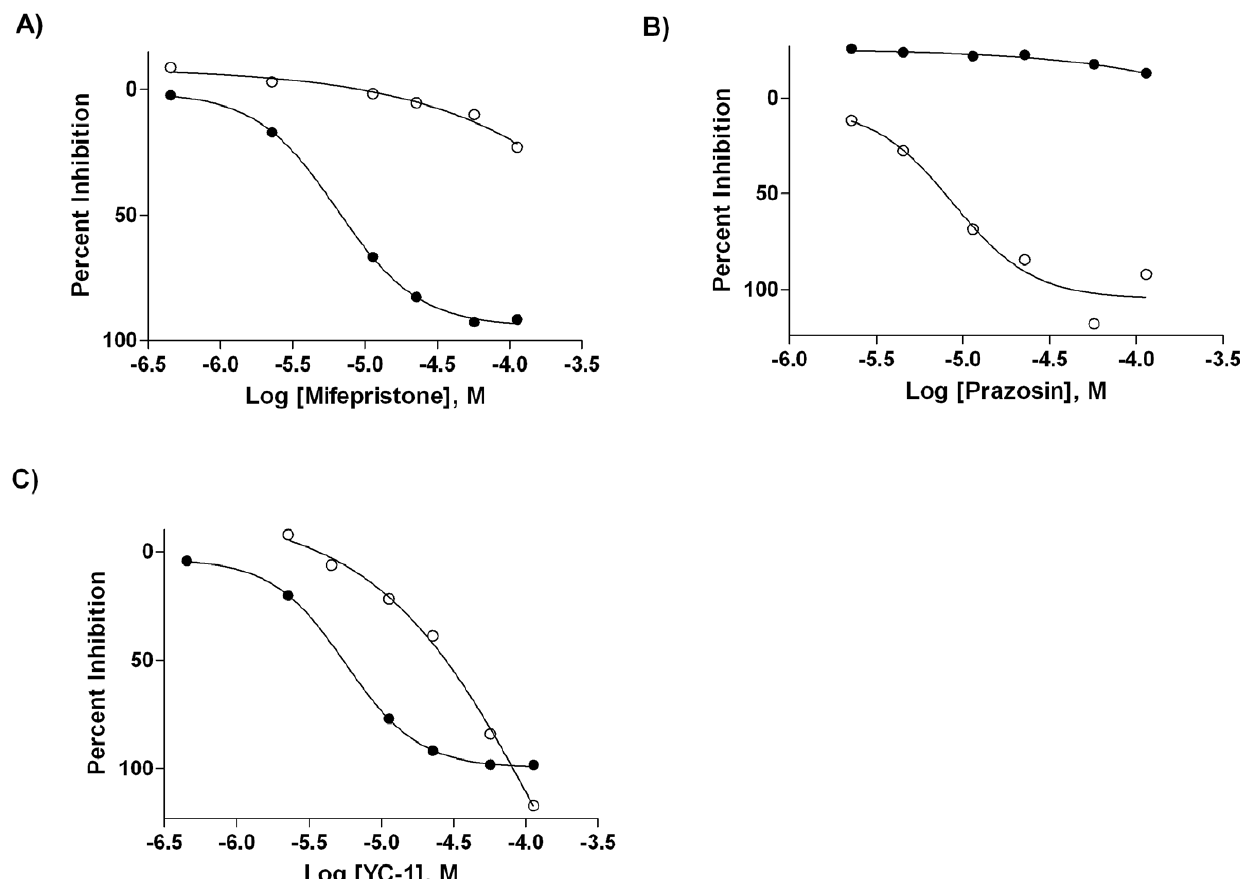
N ) and HSA ( # ) LOPAC 1280 screens. points, 0 to 100 m M) with 0.4 m M dipyridamole where 20 m L of each AGP concentration (n =3) were dispensed into a 384-well assay plate (black solid bottom, medium binding, Kalypsys/Wako,